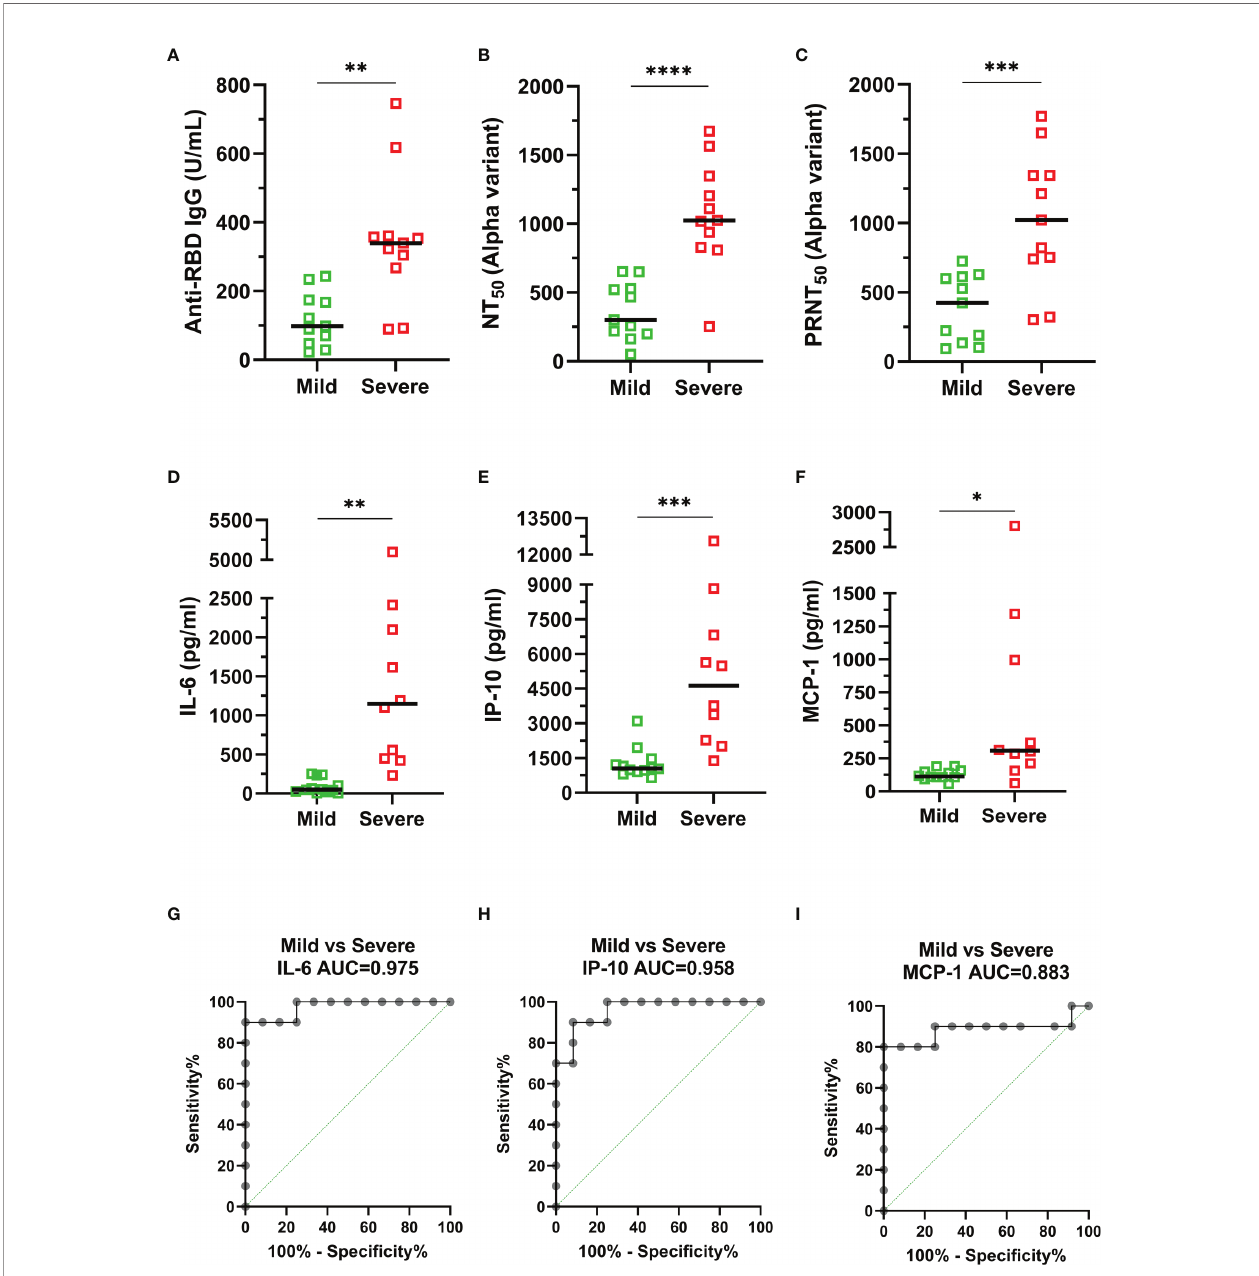
FIGURE 3 | Comparison of relevant indicators between mild (green) and severe (red) COVID-19 con fi rmed patients. (A) Anti-RBD IgG. (B) NT 50 (alpha variant). (C) PRNT 50 (alpha variant). (D) IL-6. (E) IP-10. (F) MCP-1. (G – I) The area under the receiver operating characteristic (ROC) curve (AUC) for serum cytokine levels: (G) IL-6, (H) IP-10, and (I) MCP-1. Duplicates were performed for each tested serum. Measured statistical signi fi cance was calculated between experiments by two- tailed Student ’ s t test. Asterisks indicate statistical signi fi cance, *p < 0.05, **p < 0.01, ***p < 0.001, ****p <